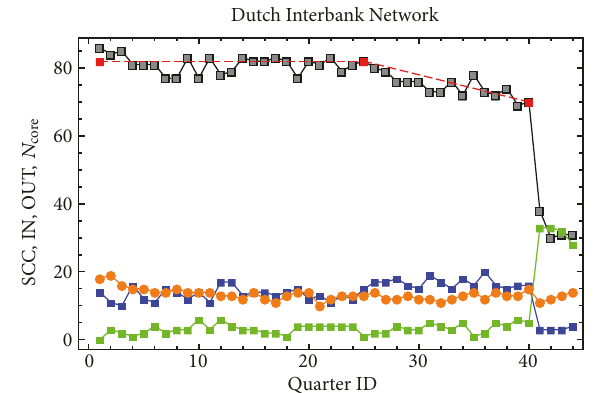
Figure 4: Evolution of the DIN bow-tie structure (the SCC is shown in gray, the IN-component is shown in blue, and the OUT- component is shown in green). The crisis period (last four points) is signalled by a sharp decrease of the SCC and IN-components size (and a corresponding increase of the OUT-component size). The size of the SCC,however,starts shrinking in 2004Q1(deviating from theapproximatelyconstanttrendobservedsince1998Q1),seemingly constituting an additional, early-warning signal of the upcoming crisis. On the other hand, the DIN core (shown in orange) does not undergo any significant variation throughout the whole temporal